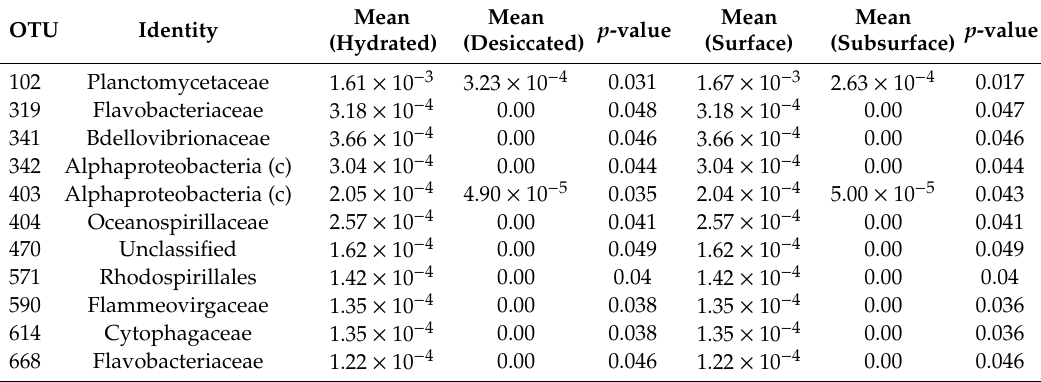
Table 3. Bacterial taxa that were significantly more abundant in 16S rRNA sequence data from a saltpan wetland in hydrated surface sediments. The means in either the hydration state or depth are the relative abundance outputs of a Metastats calculation. The lowest level taxonomy of each classified OTU is presented. Many of the taxa are potential marine transients, while others are possible resident halophiles.